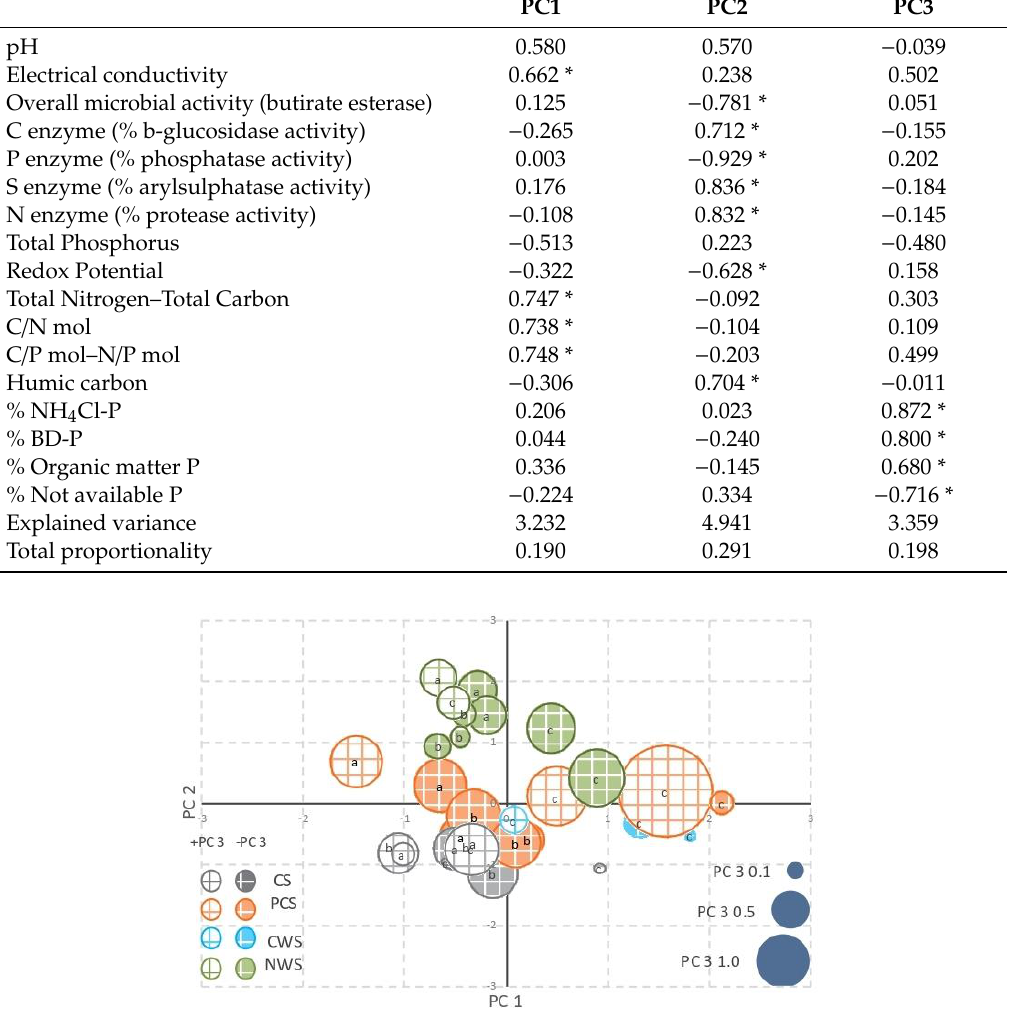
Table 6. Principal component analysis (PCA) loadings. *, parameters used for PCA interpretation.